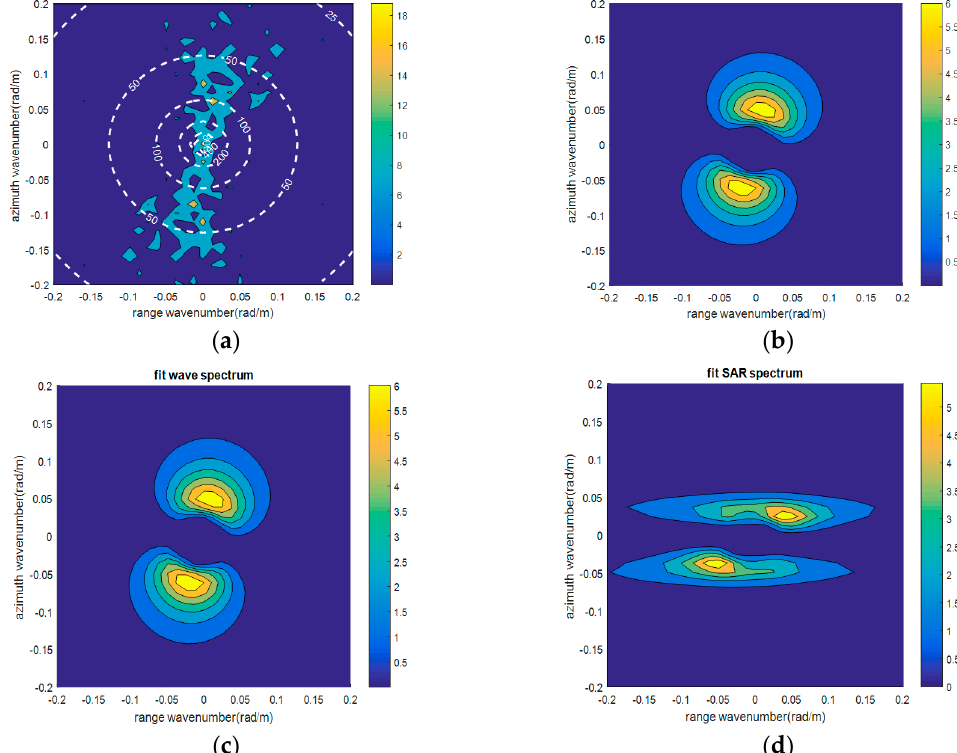
Figure 12. SAR-2: MPI algorithm inversion results as follows: ( a ) Observed SAR spectrum (after horizontal flip), ( b ) first guess PM wave spectrum, ( c ) fit PM wave spectrum, and ( d ) fit SAR spectrum.